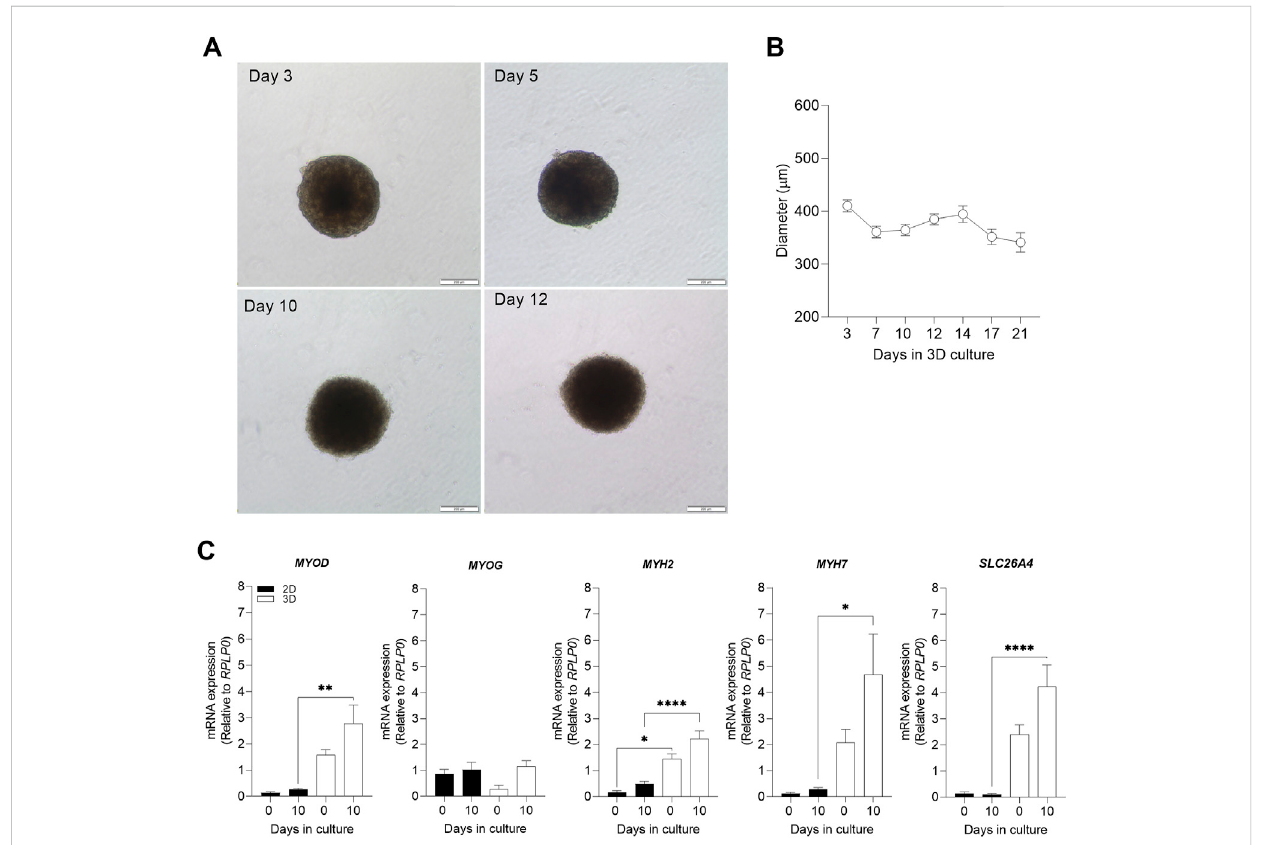
FIGURE 1 Evaluation of 3D morphological parameters and comparison of muscle cell differentiation markers in 2D and 3D models. Myospheres were formed in the ultra-low attachment treatment (ULA) 96-well plate system and differentiation was carried out between 0 and 21 days. After 10 days of differentiation, mRNA was isolated, and gene expression was analyzed by qPCR. (A) Phase-contrast photos of myospheres during 3, 5, 10 and 12 of differentiation. Area (B) and diameter (C) were analyzed by AnaSP for up to 21 days of differentiation. (D) mRNA expression of the muscle differentiation markers MYOD, MYOG, MYH2, MYH7 , and SLC26A4 before (day 0) and after differentiation (day 10), normalized to housekeeping gene ( RPLP0 ). Scale bar = 200 µm. Results are presented as mean ± SEM. * p < 0.05 ** p < 0.01 **** p < 0.0001 by ordinary one-way ANOVA